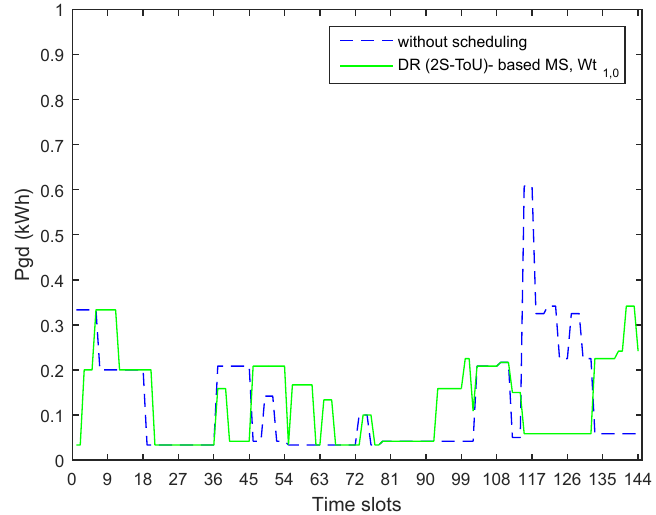
Figure 10. Load profile with maximal reduction in CE for 2S-ToUP (MS).